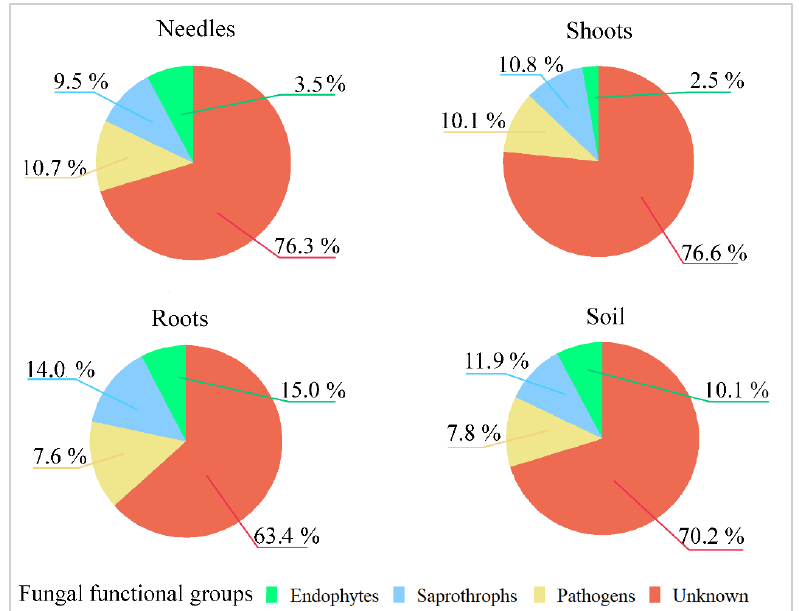
Figure 6. Fungal functional groups in the needle, shoot, root, and soil samples from the 30 sampling sites of Pinus sylvestris are shown as a relative abundance (%) of the total number of fungal taxa. Generalized linear mixed effect models showed that species richness of fungal OTUs associated with roots increased with the increase of stand age while the opposite was the case for fungi in needles and organic soil (Chisq = 89, df = 4, p < 0.05). The stand age did not have an effect on the fungal species richness in shoots or the mineral soil (Figure 7A).